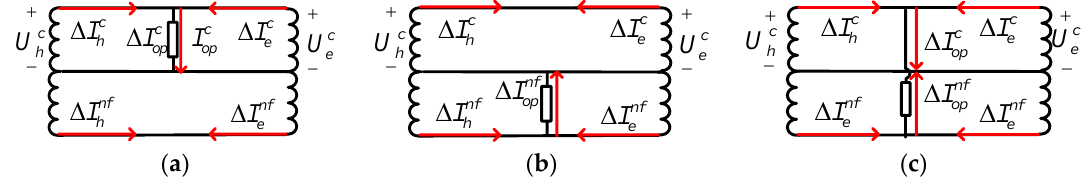
Figure 8. Current and voltage distribution at the AT subsection in the cases of fault with high transition resistance: ( a ) In C-G short circuit; ( b ) in NF-G short circuit; and ( c ) in C-NF short circuit.